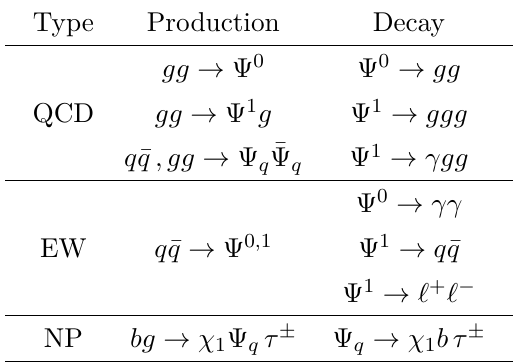
Table 2 . The main Ψ -meson production and decay modes for each type of interaction at the